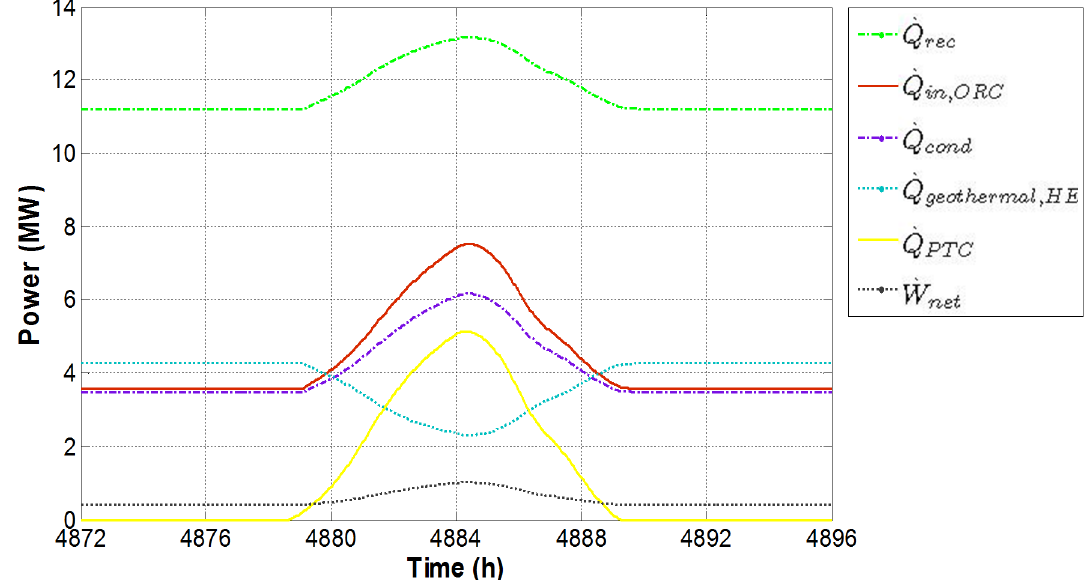
Figure 6. Powers of system in a summer